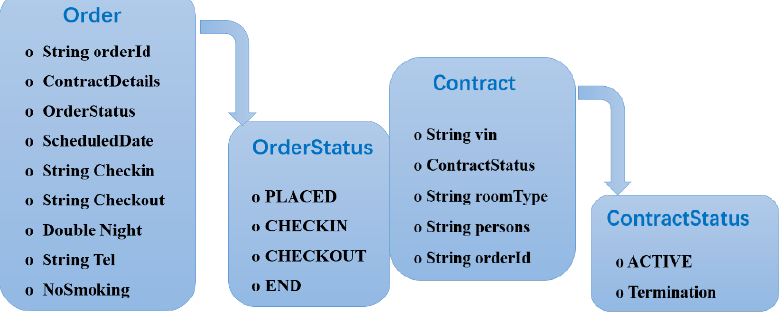
Figure 15. Order asset definition and contract asset definition in Hyperledger Fabric smart contract.